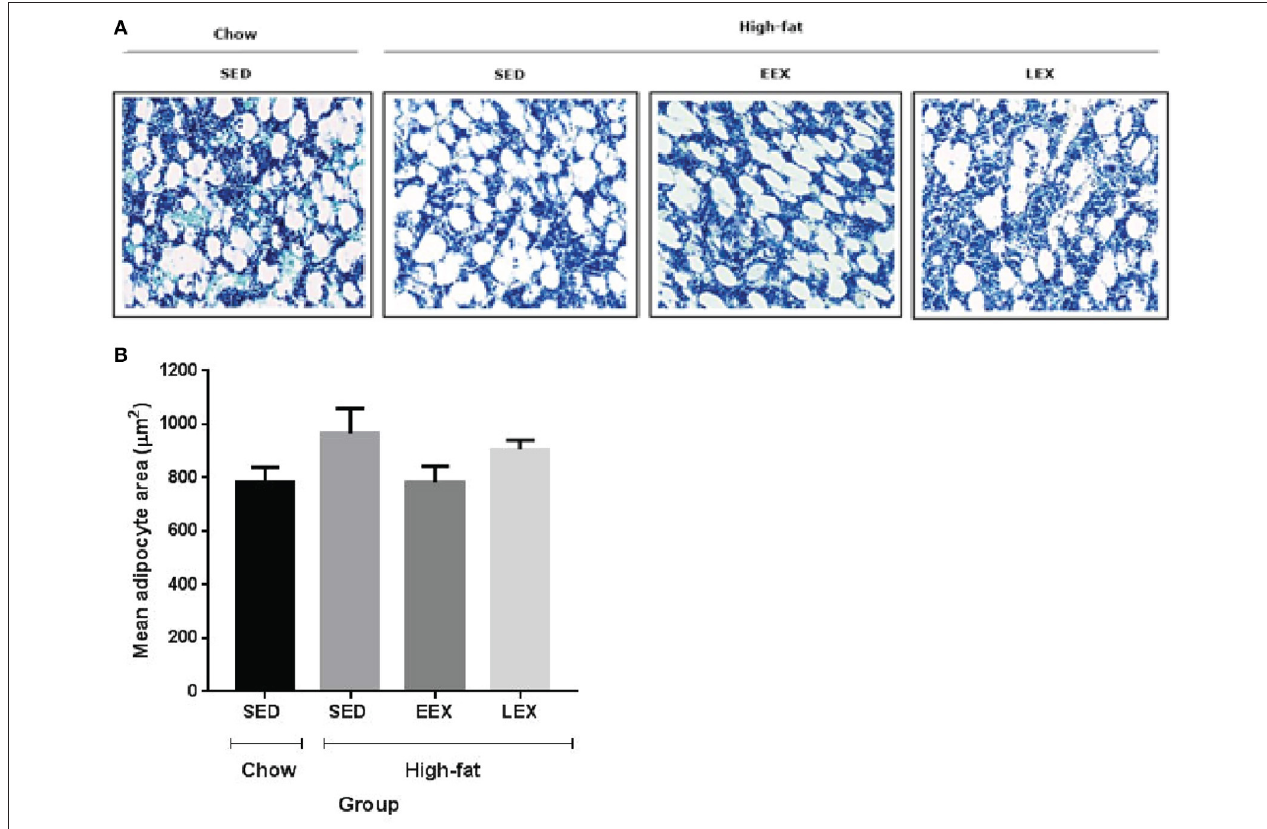
FIGURE 2 | Mean marrow adipocyte area of the experimental groups at D 120 . (A) Representative images of bone marrow adipocytes in the experimental groups. (B) Graphical representation of mean adipocyte area. There were no statistically significant differences between any of the experimental groups with respect to their bone marrow adipocyte area. However, the mean marrow adipocyte area of the HF-SED group was larger than C-SED, HF-EEX, and HF-LEX